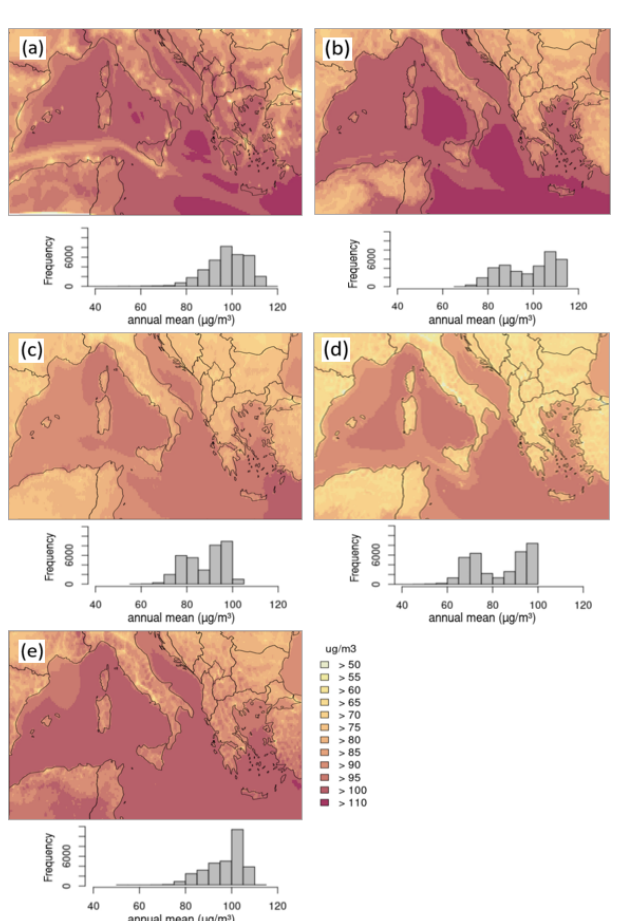
Figure 9. Annual mean O 3 potential ship impact. (a) CAMx; (b) CHIMERE; (c) CMAQ; (d) EMEP; (e) LOTOS-EUROS; white areas in the panels display values below − 20%. Below the domain figure the respective frequency distribution is displayed for the an- nual mean O 3 potential ship impact, referring to the whole model